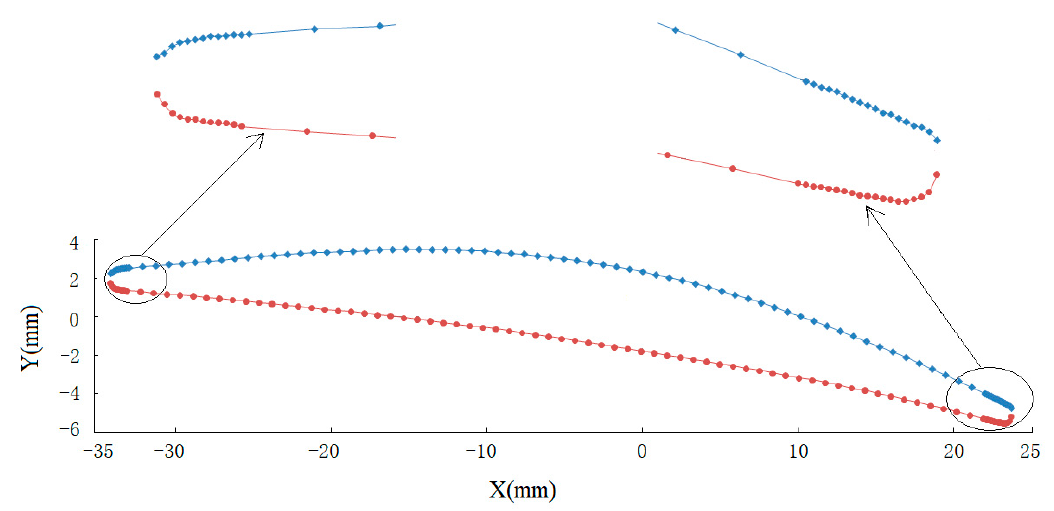
Figure 7. Curves of the leading and trailing edges extracted based on a priori planning technique.